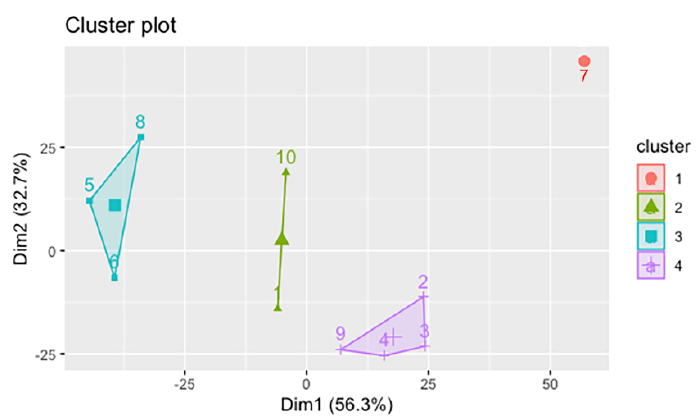
Figure 14. Cluster analysis by the k-means method (n = 4): 1—G1; 2—G2; 3—G3; 4—I1; 5—L1; 6—L3; 7—I2; 8—L2; 9—I3; 10—I4 .